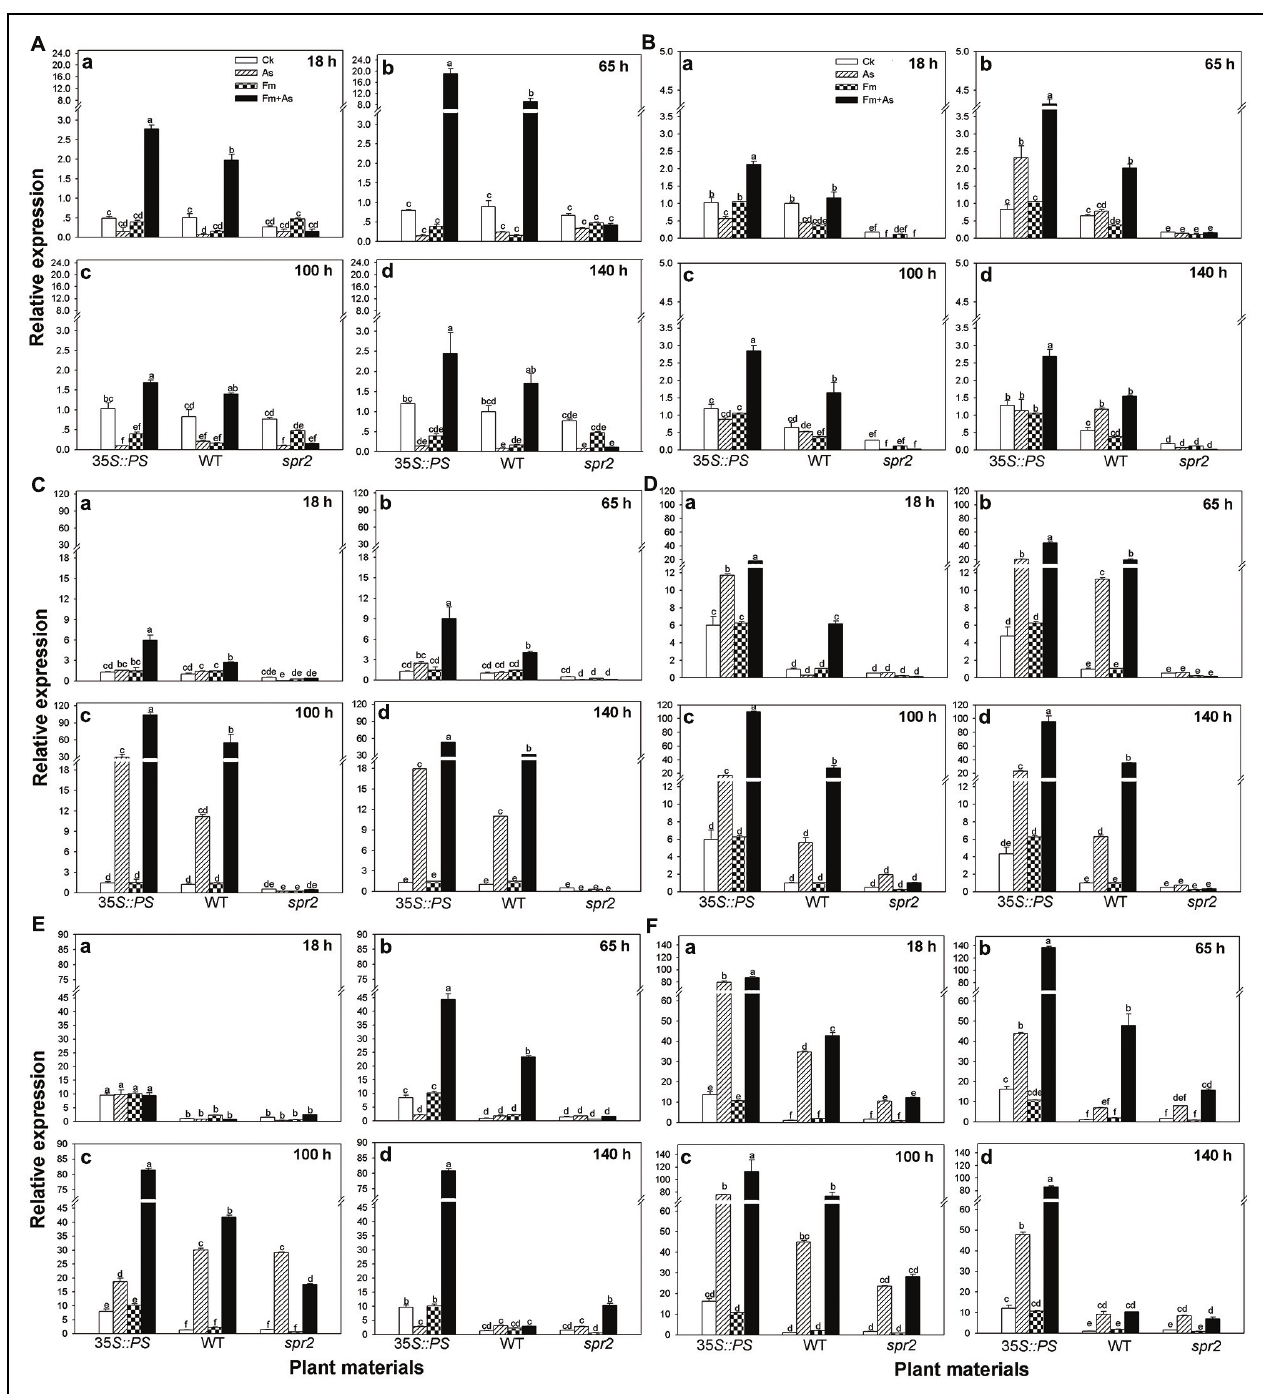
FIGURE 5 | Transcripts of defense-related genes in leaves of tomatoes with mycorrhizal colonization and pathogen infection. WT and mutant plants ( 35S::PS and spr2 ) of tomato were pre-inoculated with mycorrhizal fungus Funneliformis mosseae and later inoculated with A. solani , the causal agent of early blight disease of tomato. Quantitative real time RT-PCR was used to detect the transcripts of six defense-related genes encoding the PAL (A) , LOX (B) , ( Pin2 ) (C) , pathogen-related proteins ( PR1 ) (D) , β -1,3-glucanase (basic type PR-2 ) (E) , and chitinase ( PR-3 ) (F) . Transcript levels were quantified 18 (a), 65 (b), 100 (c), and 140 h (d) after pathogen inoculation. Four treatments included: (1) CK: control plants without pathogen and mycorrhizal inoculation; (2) As: plants inoculated with A . solani only; (3) Fm: plants inoculated with F. mosseae only; (4) Fm + As: plants inoculated with both F. mosseae and A . solani . Three tomato genotypes included: (1) WT: wild type plant; (2) 35S::PS : Prosystemin-overexpressing 35S::PS plant; (3) spr2 : JA biosynthesis mutant plant. Values are means ± SE from three sets of independent experiments with three pots per treatment for each set of experiments. Significant differences among treatments were tested at P = 0.05 by Tukey post hoc